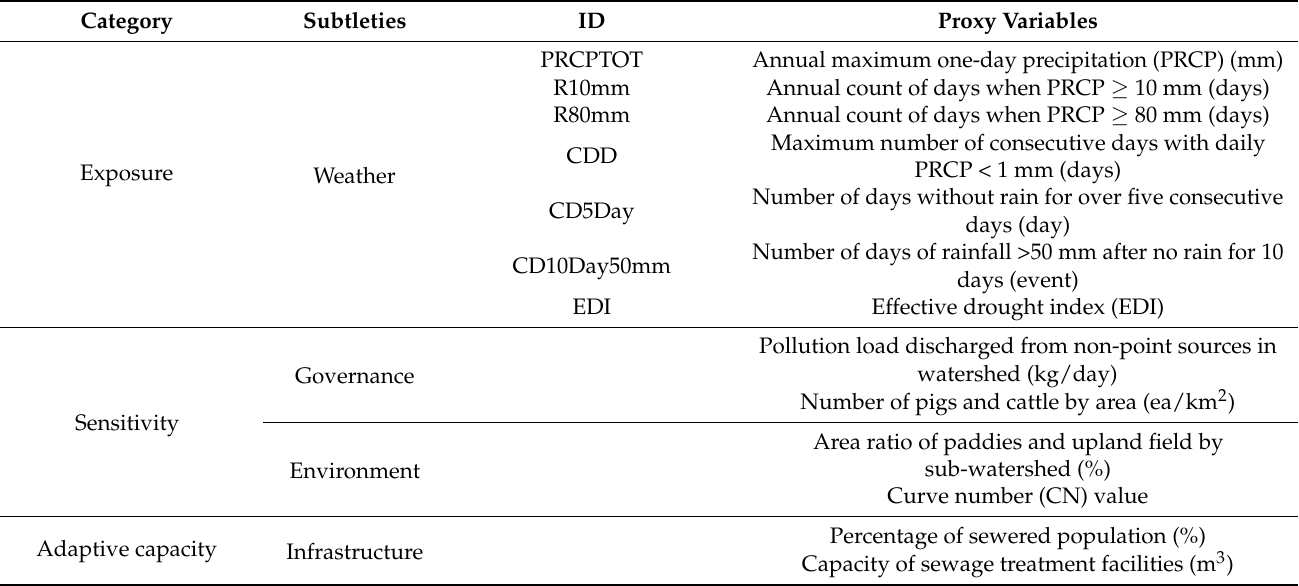
Table 1. List of proxy variables that describe climate exposure, sensitivity, and adaptation